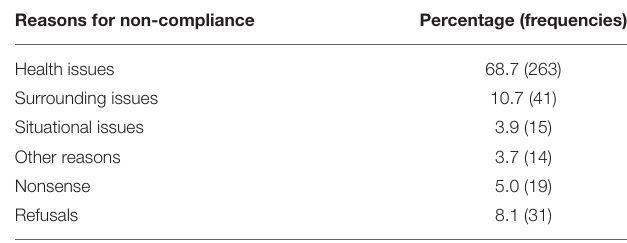
TABLE 1 | Reasons for non-compliance with the squat